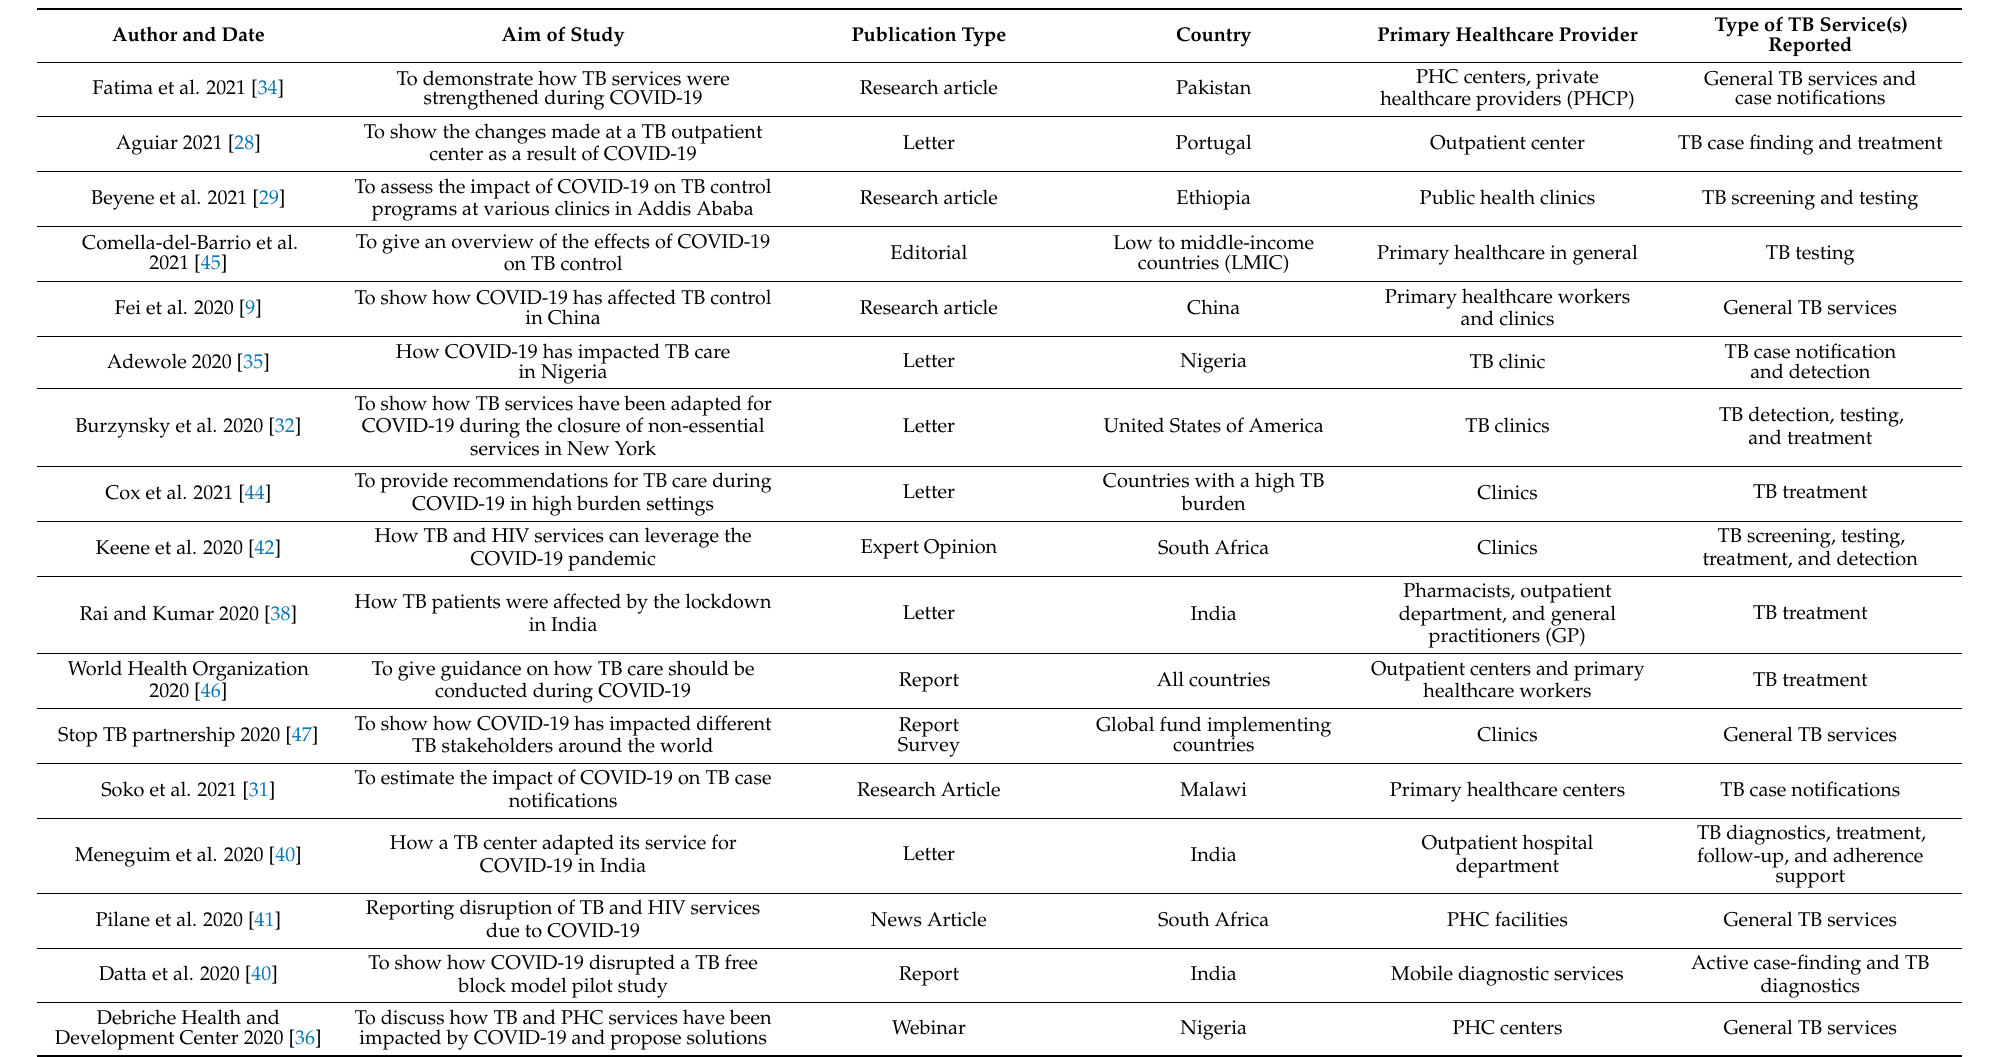
Table 3. Characteristics of the included